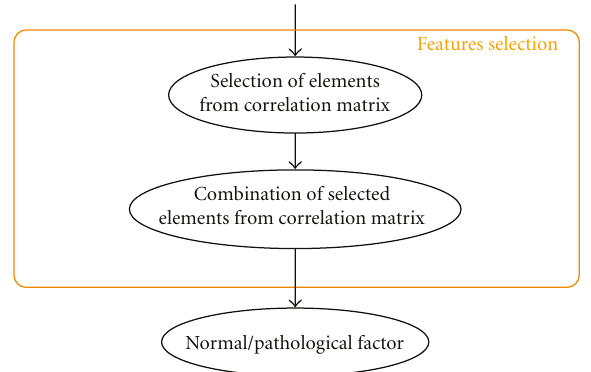
Figure 8: Details of the third part of the analysis system.